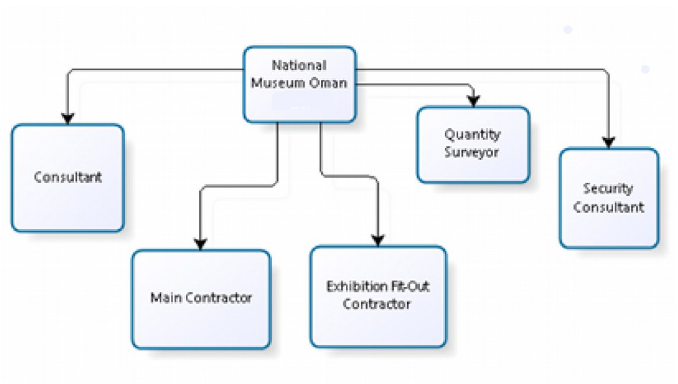
Figure 1. General map of the work